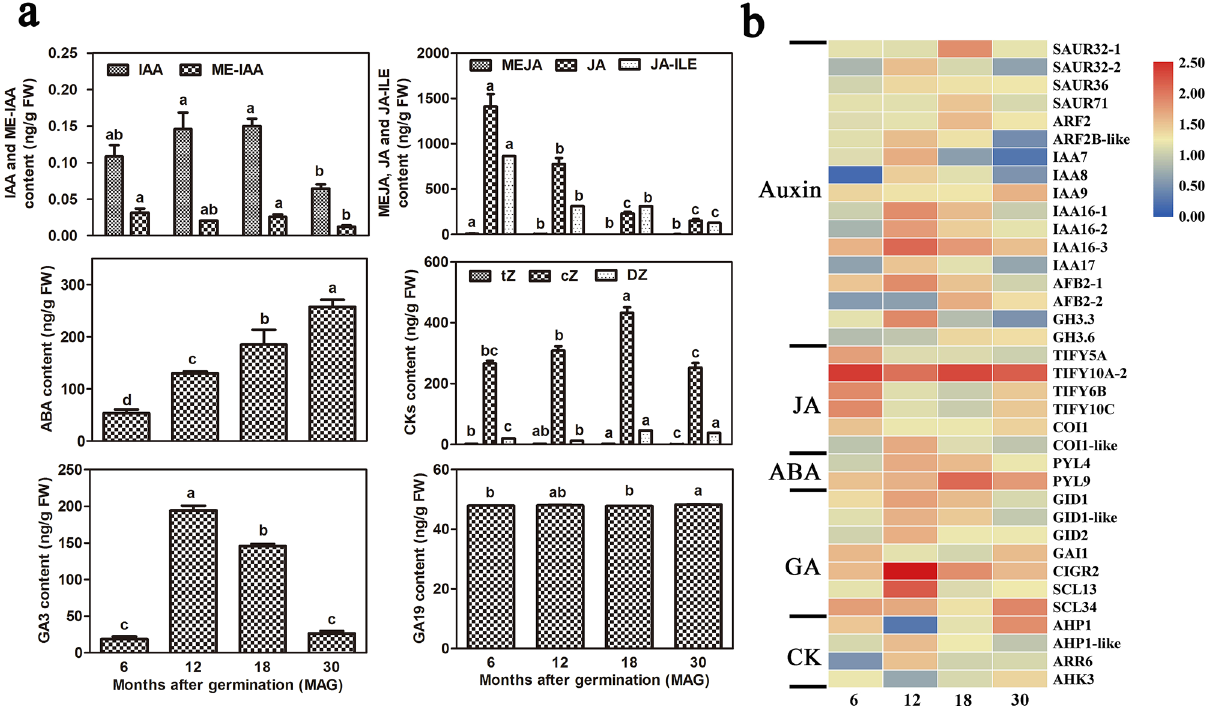
Figure 4. Trends in endogenous phytohormone contents ( a ) and expression profiles of hormone related DEGs ( b ) in C. speciosa roots. ( a ) Trends in endogenous phytohormone contents. ( b ) The expression profiles of genes encoding hormone signaling. Heat map indicates the log 10 -transformed FPKM expression values. Changes in expression level are indicated by a change in color; from blue to red indicates an expression level from low to high. All data shown reflect the mean of three biological replicates ( n = 3). Means with different letters in each sample represent a significant difference at 0.05